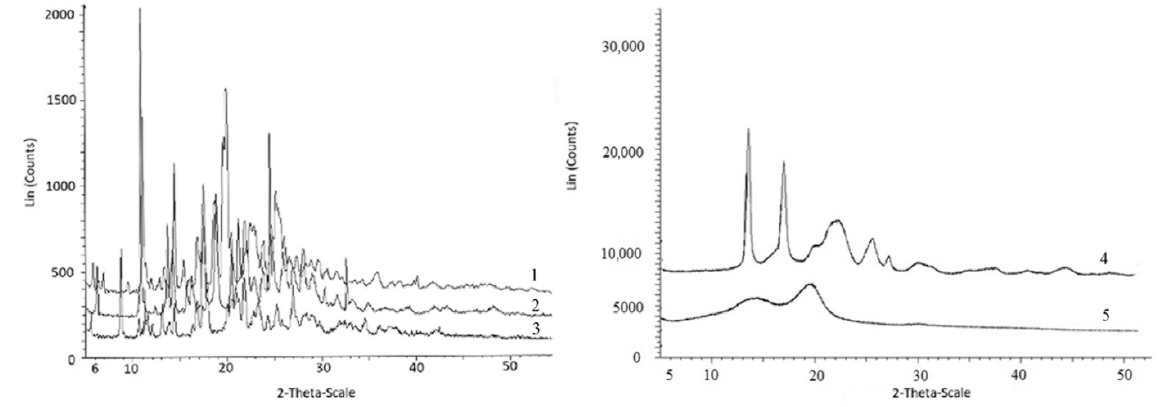
Figure 2. X-ray spectra of initial matrix materials and fungicides: 1—difenoconazole; 2—azoxystrobin; 3—prothioconazole and materials of the matrix 4—P(3HB) and 5—birch wood flour.